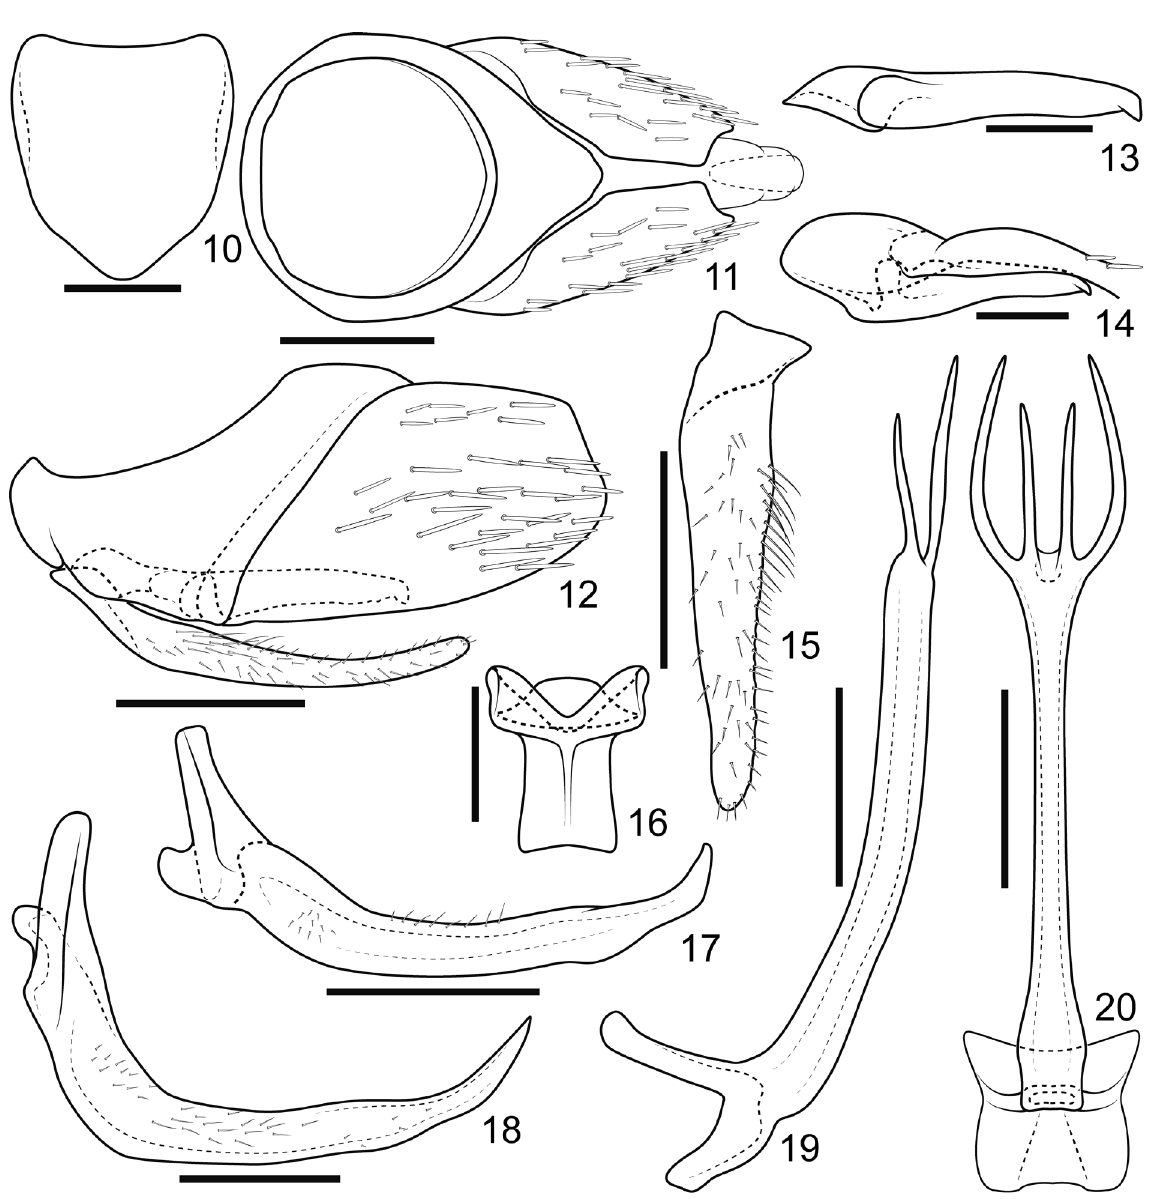
Figs 10–20. Guaricicana borgesi gen. et sp. nov., holotype, ♂ (DZUP 215374), terminalia. 10 . Sternite VIII, ventral view. 11 . Pygofer, dorsal view. 12 . Pygofer and subgenital plate, lateral view. 13 . Ventral process of pygofer, lateral view. 14 . Ventral process of pygofer, ventral view. 15 . Subgenital plate, ventral view. 16 . Connective, dorsal view. 17 . Style, dorsal view. 18 . Style, lateral view. 19 . Aedeagus, lateral view. 20 . Aedeagus, ventral view. Scale bars: 10–12, 15, 17–18 = 0.5 mm; 13–14, 16, 19–20 = 0.25